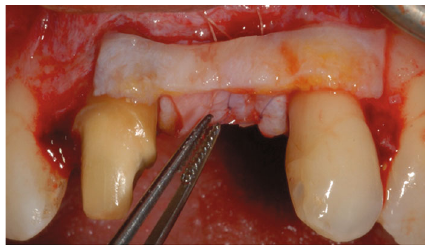
Figure 7: First part of the second deepithelialized free gingival graft sutured on the buccal side.